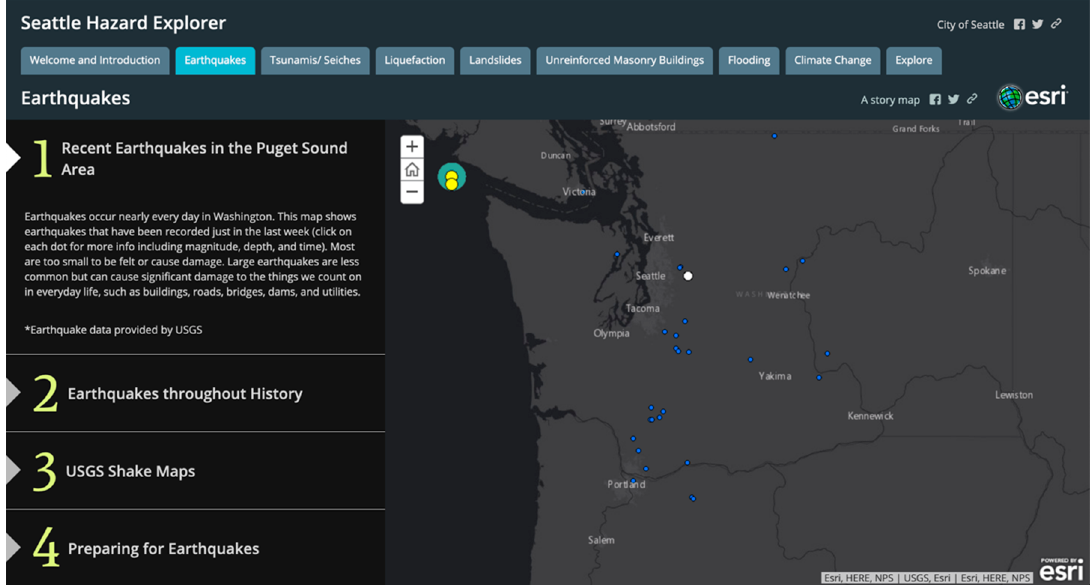
Figure 6. Story map for the Corinthian Gulf and municipalities around it (https://tinyurl.com/wrewbga).